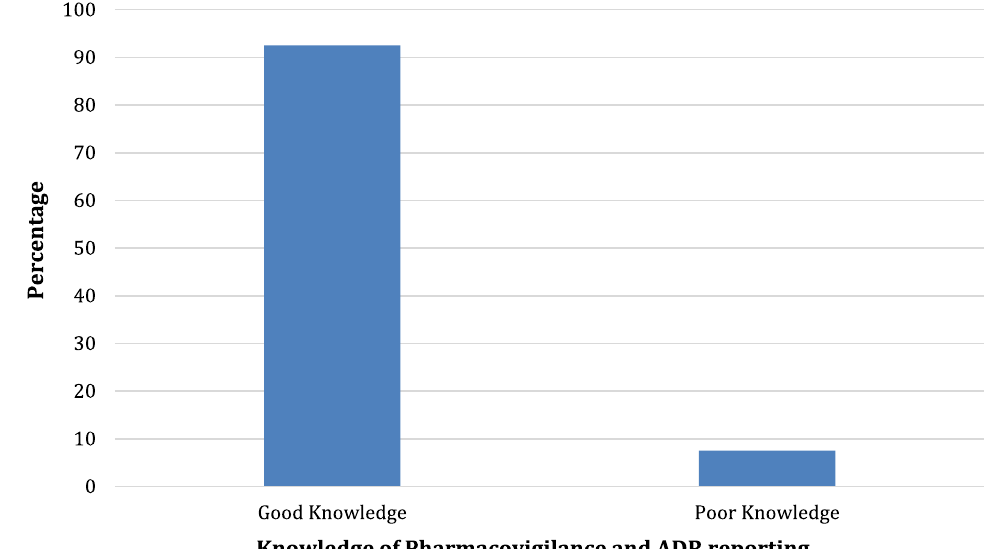
450). 92.5% of the participants had a good =